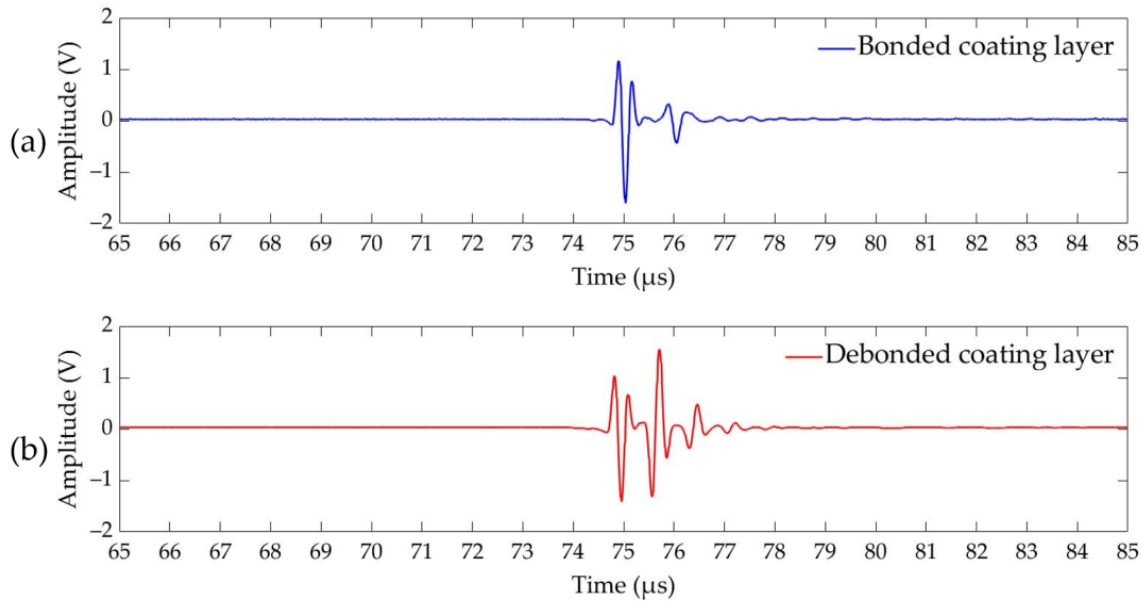
Figure 4. Received waveform from ( a ) bonded and ( b ) debonded coating layers.